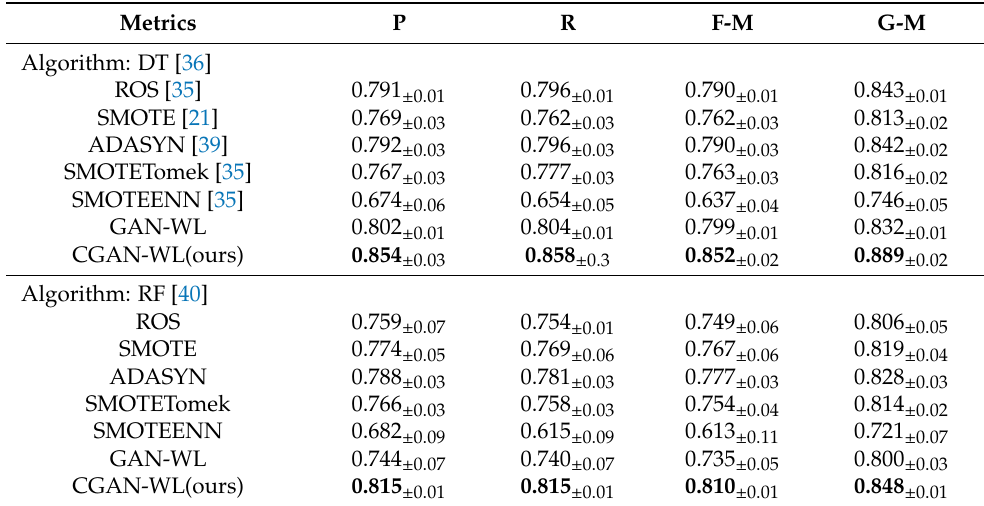
Table 2. Averages of metrics by different methods using different classifiers. The bold characters are highlighted as best